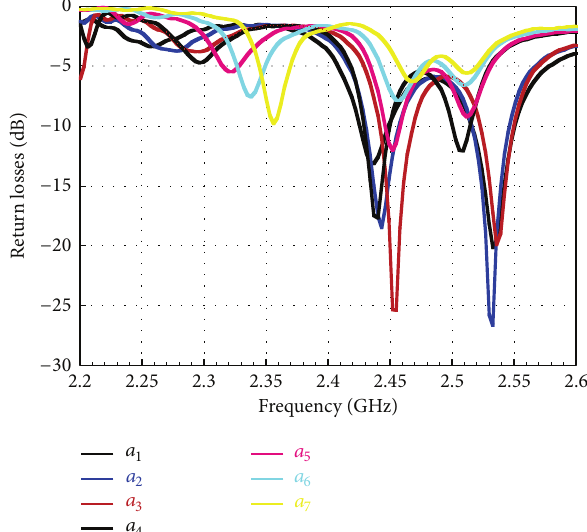
Figure 4: Return losses (short load line analysis).